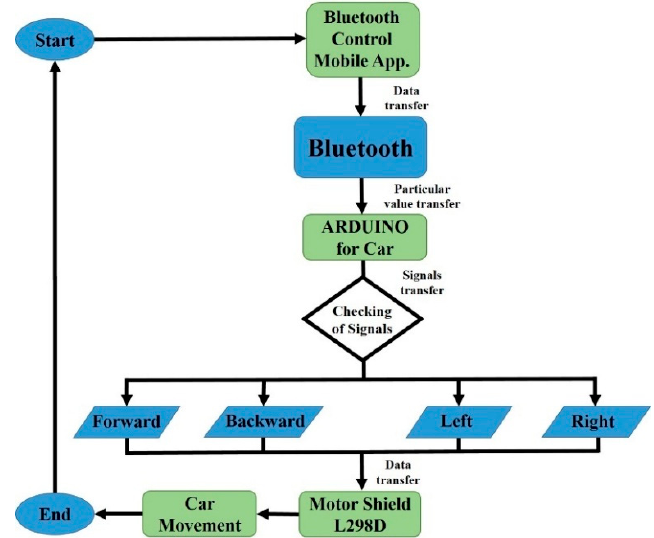
Figure 7. The flow diagram to control robot car with mobile-application.